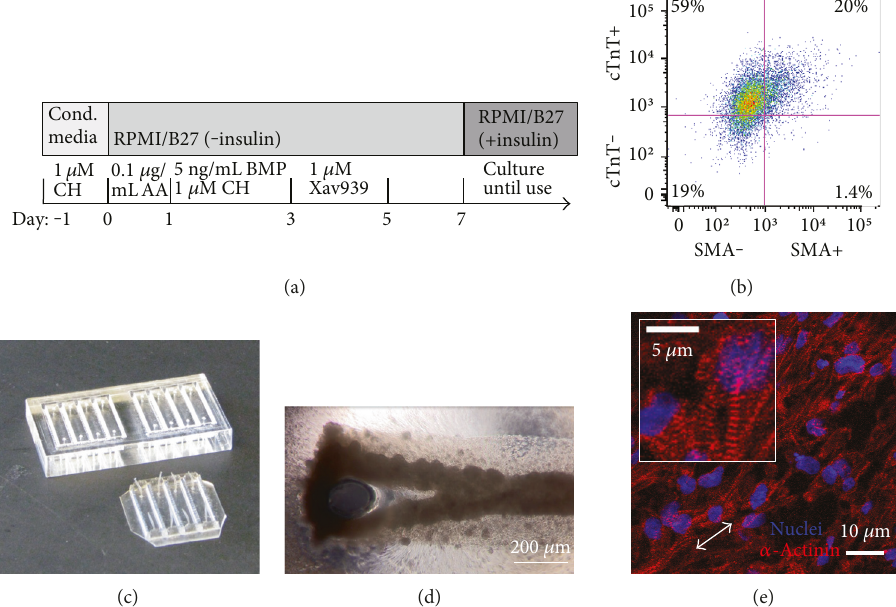
Figure 1: Directeddi ff erentiationofhESCsresultinhighlyenrichedcardiomyocytepopulationswhichformbeatingtissues invitro .(a)Timeline of di ff erentiation of cardiomyocytes from hESCs (Cond. media: MEF-conditioned media, CH: Chiron99021, AA: activin A, BMP: bone morphogenic protein 4). (b) Di ff erentiated populations were immuno fl uorescently stained for cardiac troponin T (cTnT) and smooth muscle actin (SMA) and analyzed with fl ow cytometry. Cardiomyocytes cultured with a collagen-1 matrix in PDMS molds cast from custom laser- etched acrylic negatives (c) remodeled the matrix and formed beating constructs within 48 hours (d). (e) Immuno fl uorescence of α -actinin (red) and nuclei (blue) in engineered tissue sections. Myo fi bril striations were visible (inset). White double-headed arrow indicates direction of uniaxial stress in tissue during